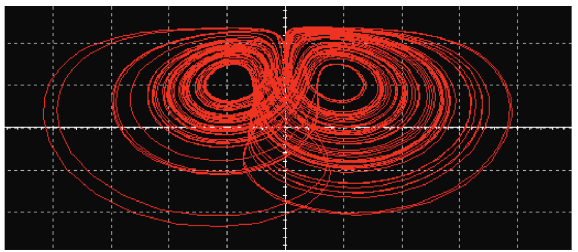
Figure 19: ( x,z ) space portrait of the Multisim simulation of equations